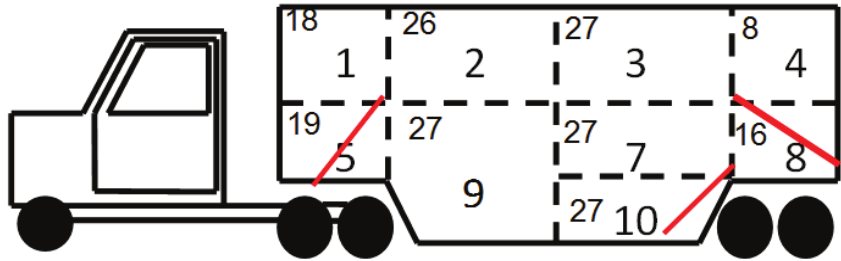
Figure 1. The location of compartments and distribution of pigs by compartment in the pot-belly trailer. Internal ramps are solid lines in compartments 5, 8, and